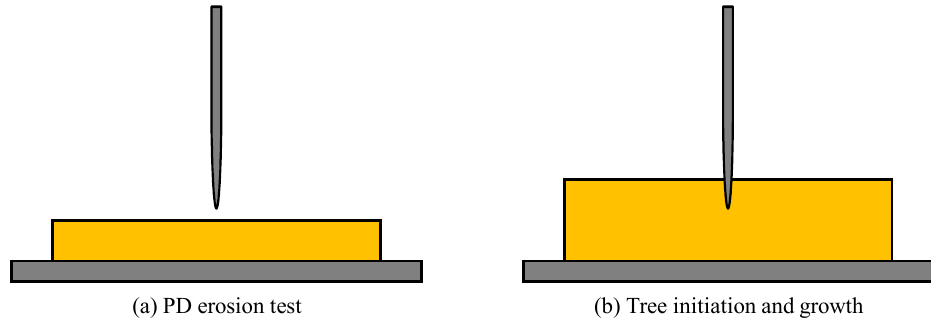
Figure 9. Electrode setup used for investigating PDs in polymer nanocomposites; ( a ) PD erosion test and ( b ) tree growth.